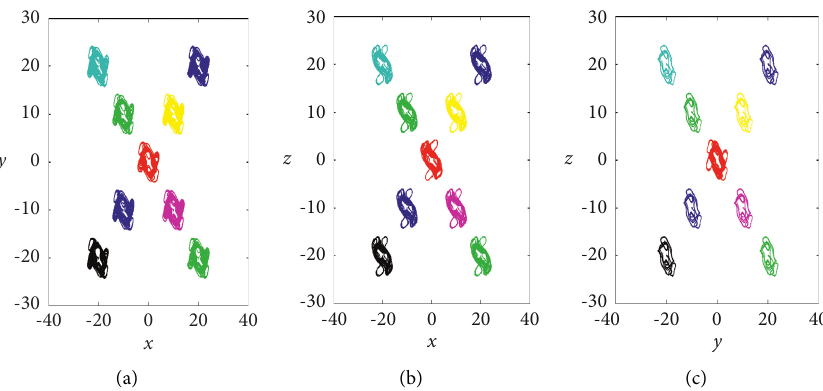
Figure 18: A 2D lattice of a variable attractor for incommensurate fractional order [ q (a) xy lattice for ( m,n ) � ( 0 , 0 ) , ( 10 , 10 ) , ( 10 , − 10 ) , (− 10 , 10 ) , (− 10 , − 10 ) , ( 20 , 20 ) , ( 20 , − 20 ) , (− 20 , 20 ) , (− 20 , − 20 ) ; (b) xz lattice for